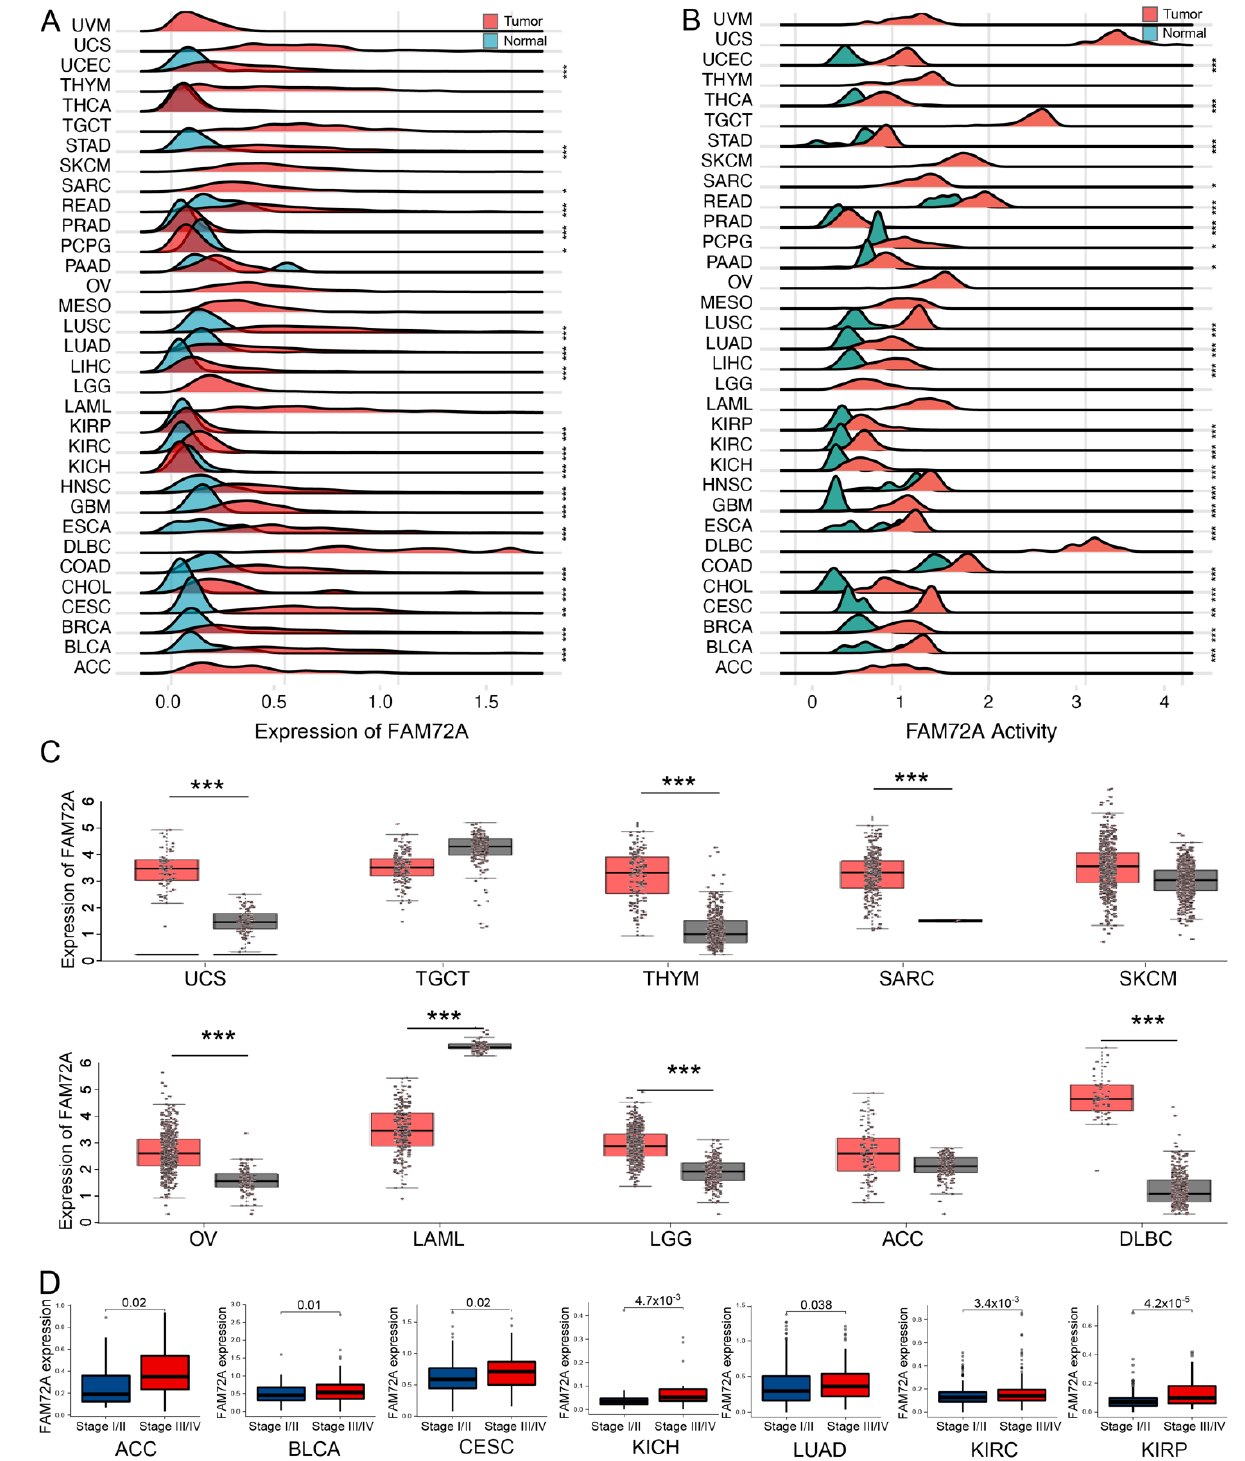
Figure 1. The expression of FAM72A in pan-cancer and different pathological stages. Differential expression ( A ) and activity ( B ) of FAM72A in normal and tumor samples of 33 tumors in The Cancer Genome Atlas (TCGA) database. ( C ). For tumors lacking corresponding normal tissue samples, the GEPIA web tool, incorporating normal tissues from the Genotype-Tissue Expression (GTEx) database, was used to compare FAM72A expression between the tumor and the normal tissues. ( D ). Expression of FAM72A in different pathological stages of indicated tumors. * p < 0.05, ** p < 0.01, and *** p < 0.001.